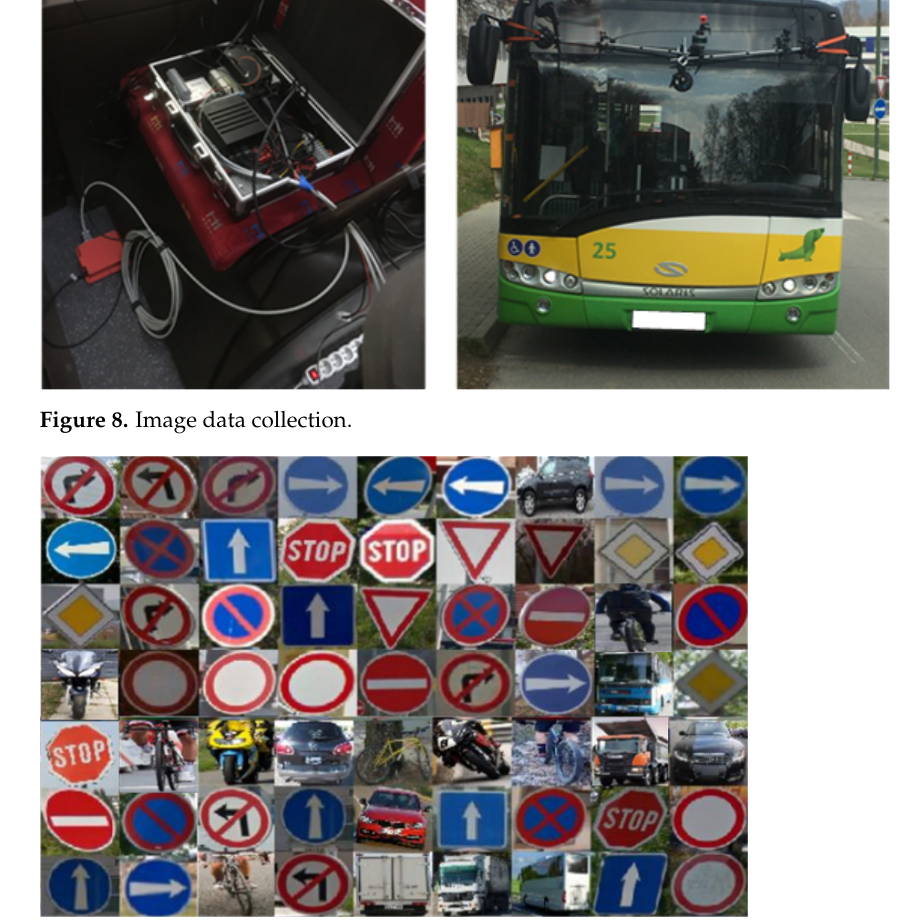
Figure 9. An example of an image dataset. Table 13. The classes in the image